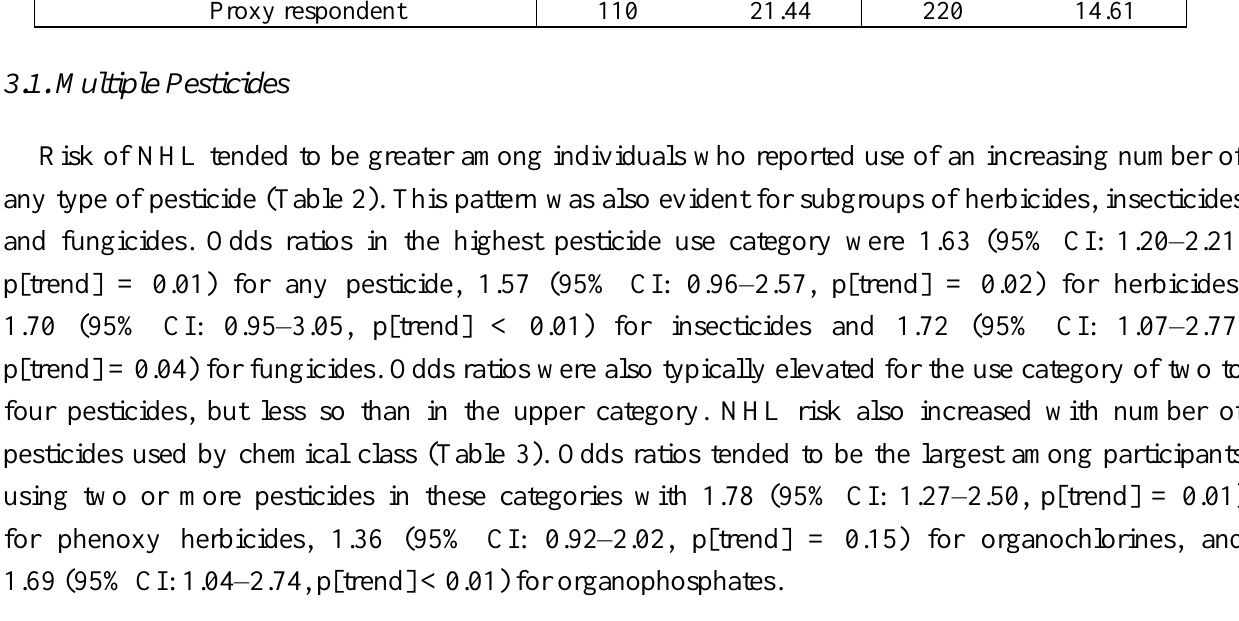
Table 2. Effect of exposure to multiple pesticides by pesticide type and carcinogenicity on